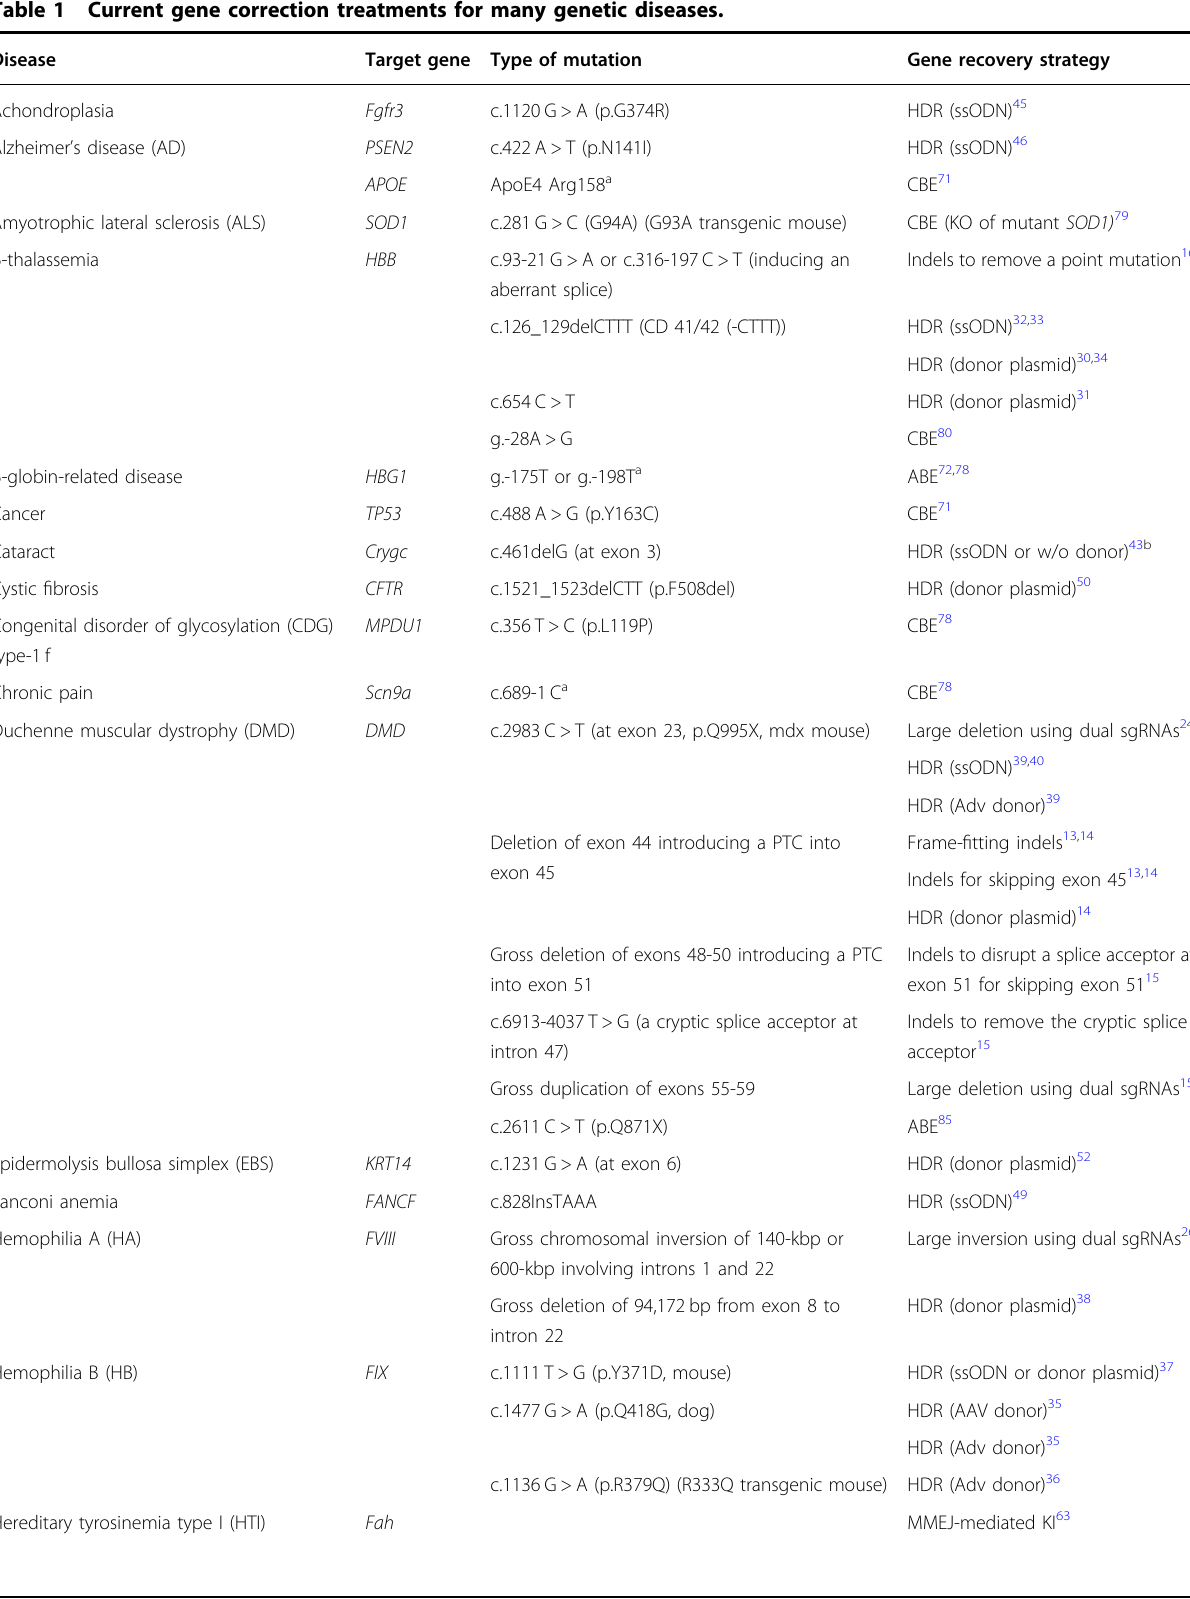
Table 1 Current gene correction treatments for many genetic